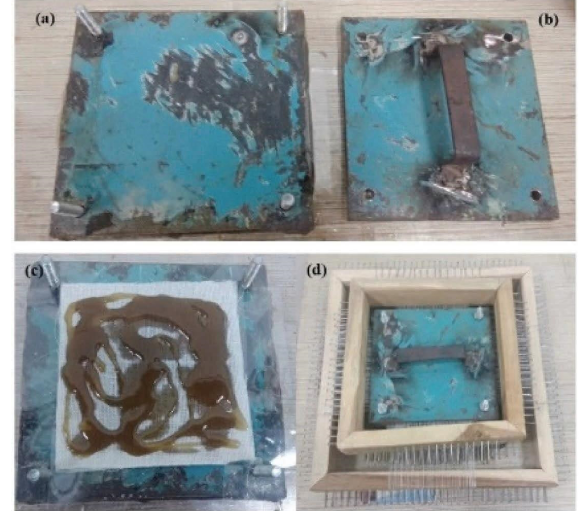
Figure 1: Te fabricated set up for the hand lay-up technique used. (a) Lower plate; (b) upper plate; (c) lower plate with matrix ma- terial; and (d) arrangement for placement of bi-axial fbres.